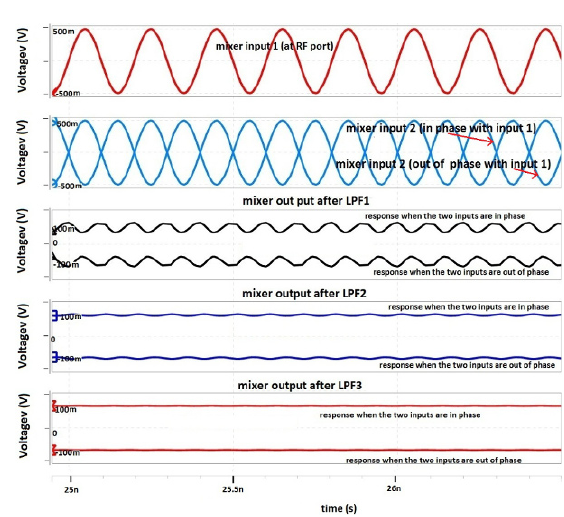
Figure 7. Zero-IF response from the mixer (Frame 1–2: mixer inputs, Frame 3–5: corresponding mixer response including the effect of LPF